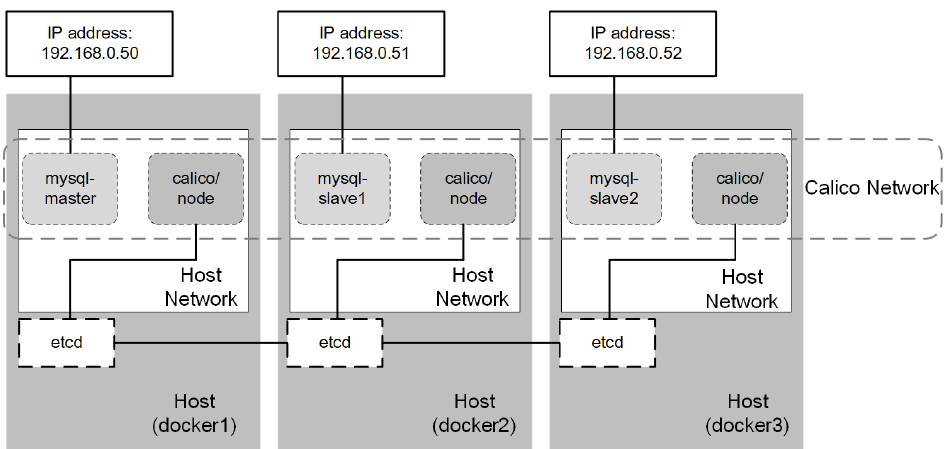
Figure 11. Multi-host networking configuration for MySQL containers based on Calico.